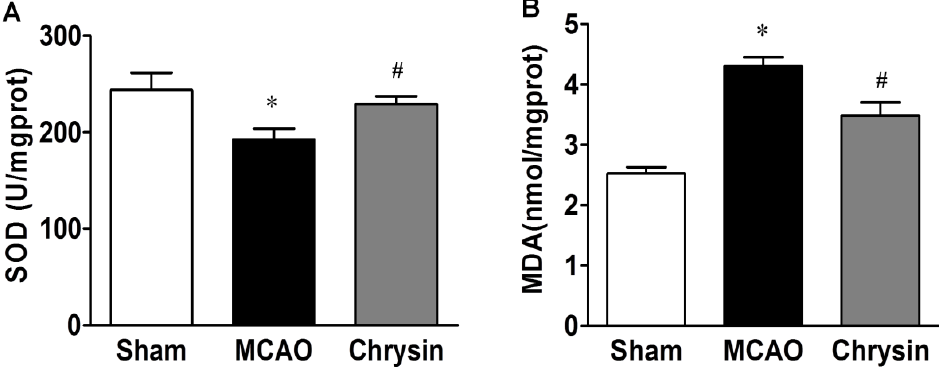
Figure 2. Effect of chrysin on the activity of SOD and the contents of MDA. ( A ) SOD activity were significantly increased in the MCAO group as compared to the sham group, Compared with the MCAO group, the activities of SOD were significantly increased in the chrysin pretreatment group; ( B ) The contents of MDA were significantly increased in the MCAO group as compared to the sham group, while it was significantly decreased in the chrysin pretreatment group. Data are expressed as means ± SEM, * p < 0.05, MCAO vs. sham group, # p < 0.05, chrysin pretreatment group vs. MCAO group, n =